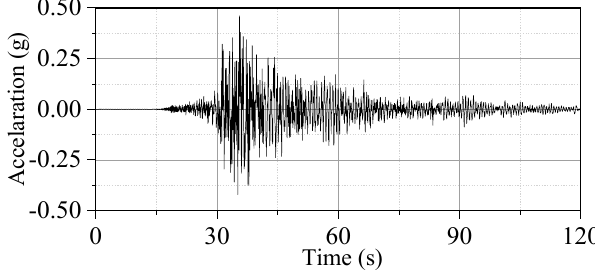
Figure 8. TKCH 080 acceleration time history records: ( a ) bedrock; ( b ) ground surface.